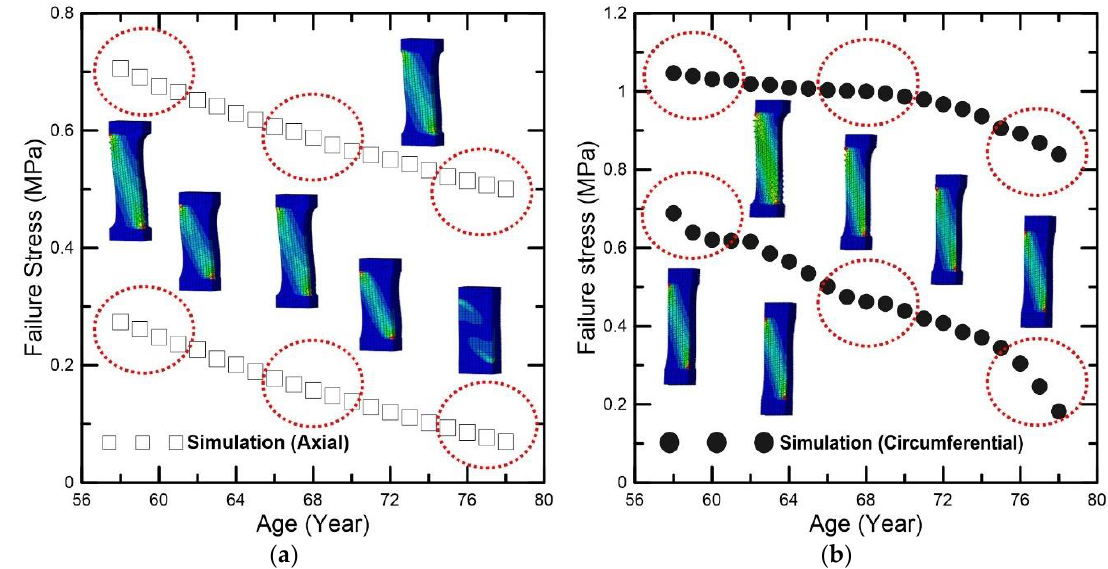
Figure 7. Simulation results under tensile loading for ( a ) axial and ( b ) circumferential directions.